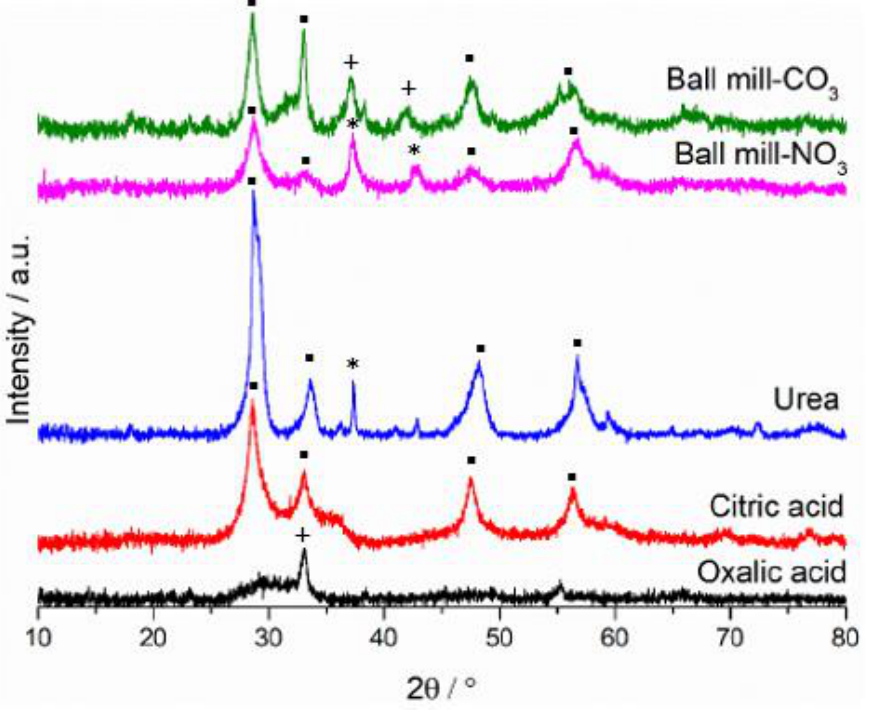
Figure 3. Powder XRD patterns of sodium carbonate co-precipitated cerium-manganese mixed —ceria phases, *—MnO 2 Table 1. Physiochemical properties extracted from XRD of cerium-manganese mixed metal oxide catalysts.